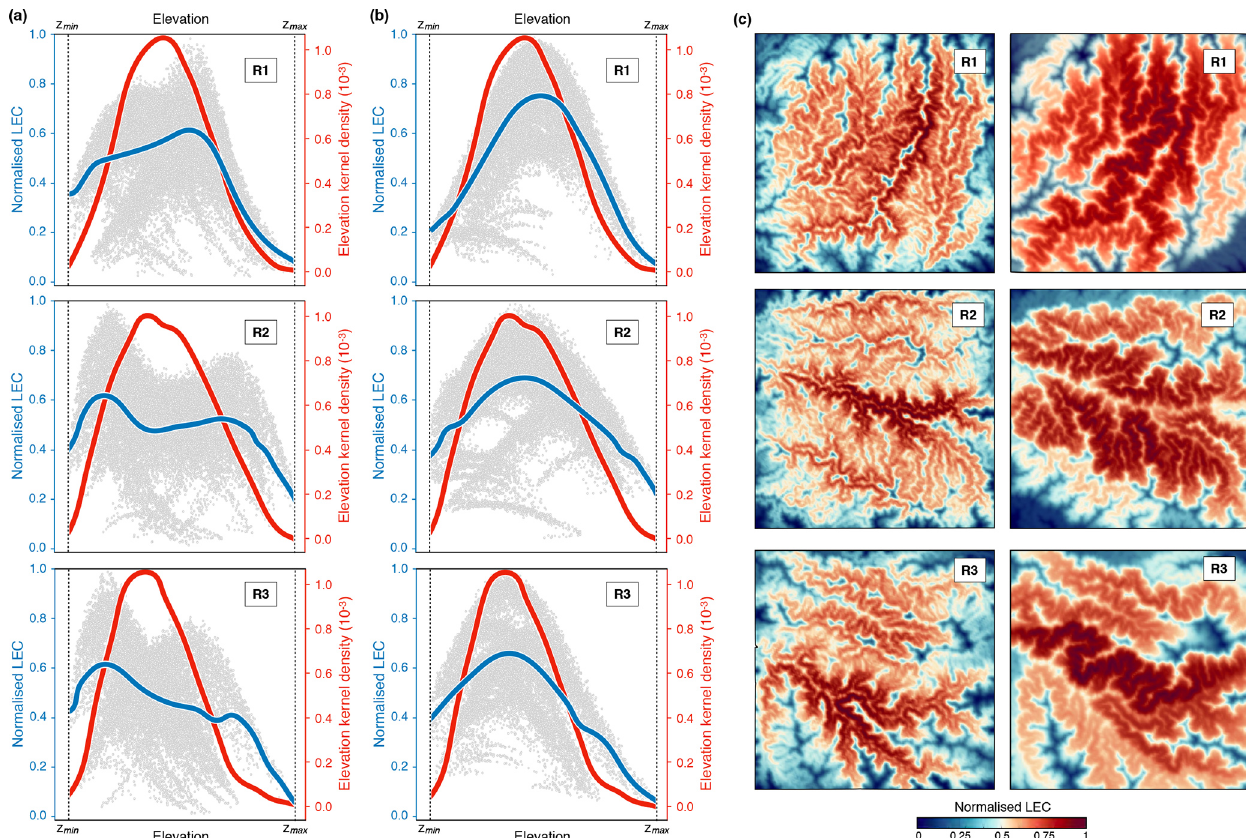
Figure 7. Connectivity results for the regions (R1, R2, and R3) presented in Fig. 6a. Panels (a) and (b) show the corresponding average line of LEC within elevational bands (blue lines) and the elevation kernel density (red lines) for two species niche width ratios of 0.1 and 0.2. Panel (c) presents the normalised connectivity map for the two width ratios and for the three